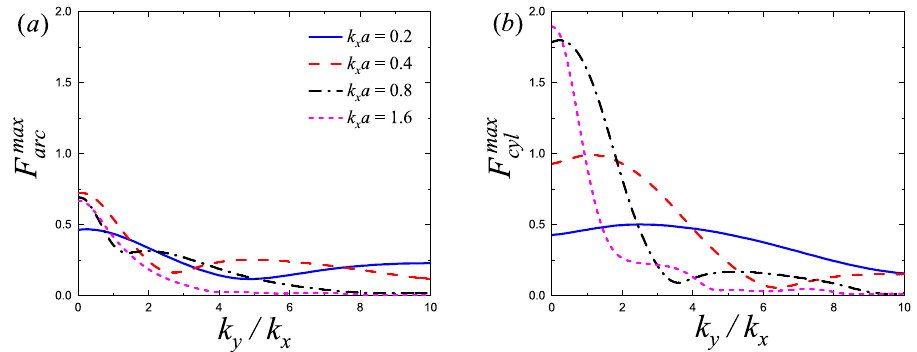
Figure 12. Variation of non-dimensional wave force on the arc wall and interior cylinder for different k x a values with a / b = 2, a / h = 1, β = π /3, G = 1, U 0 = 0.4 m/s, α = 2 π /3, and γ = 2 π /3: ( a ) arc wall; ( b ) interior